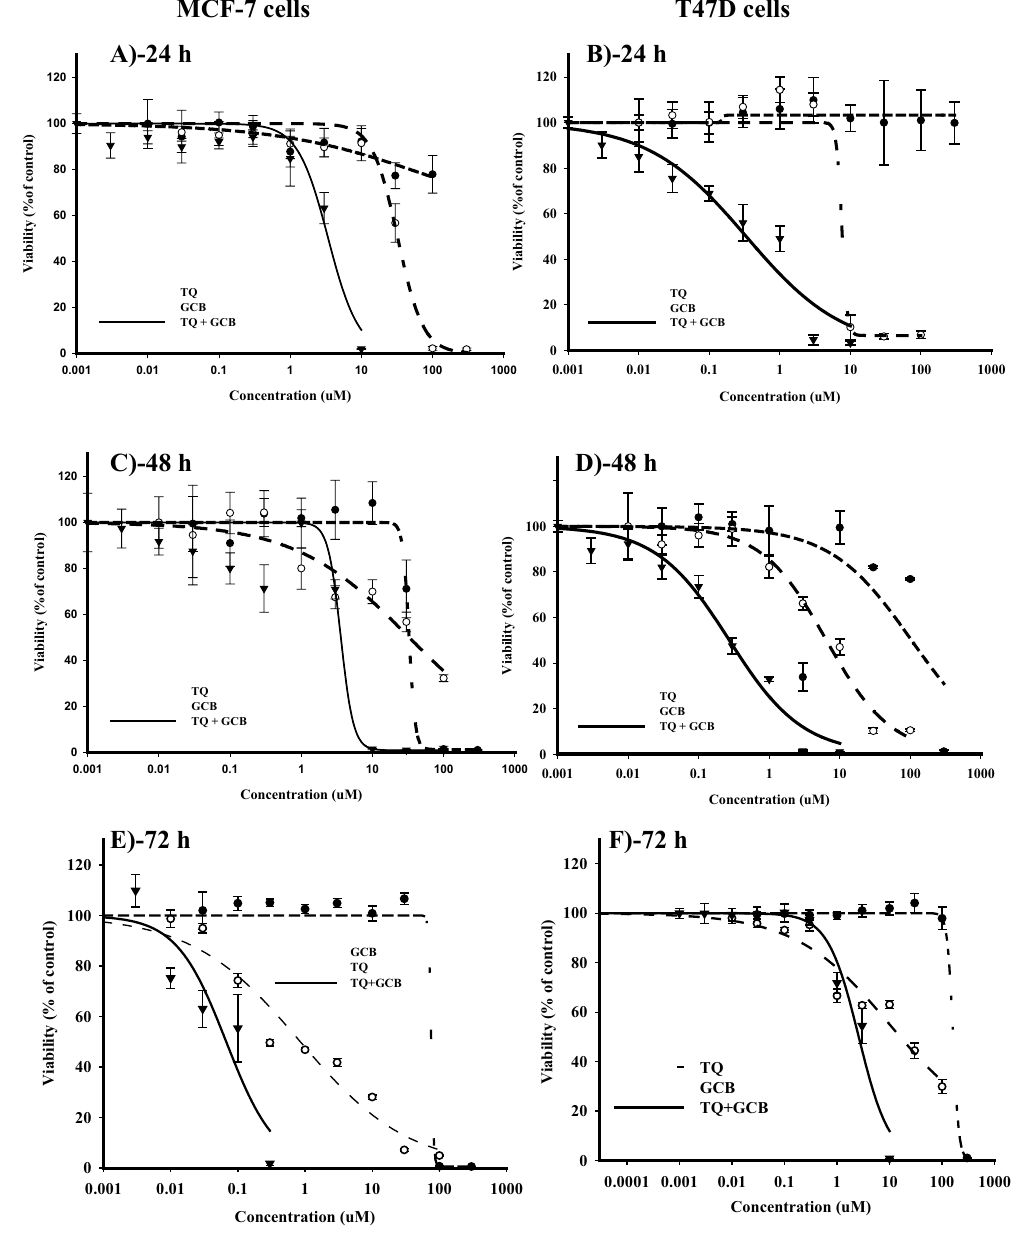
Figure 1. The chemomodulatory effect of TQ on the cytotoxicity of GCB in MCF-7 ( A , C and E ) and T47D ( B , D and F ) breast cancer cell lines. Cells were exposed to serial dilution of GCB, TQ or their combination for 24 h ( A and B ), 48 h ( C and D ) 72 h ( E and F ). Cell viability was determined using SRB-assay and data are expressed as mean ± SD (n =